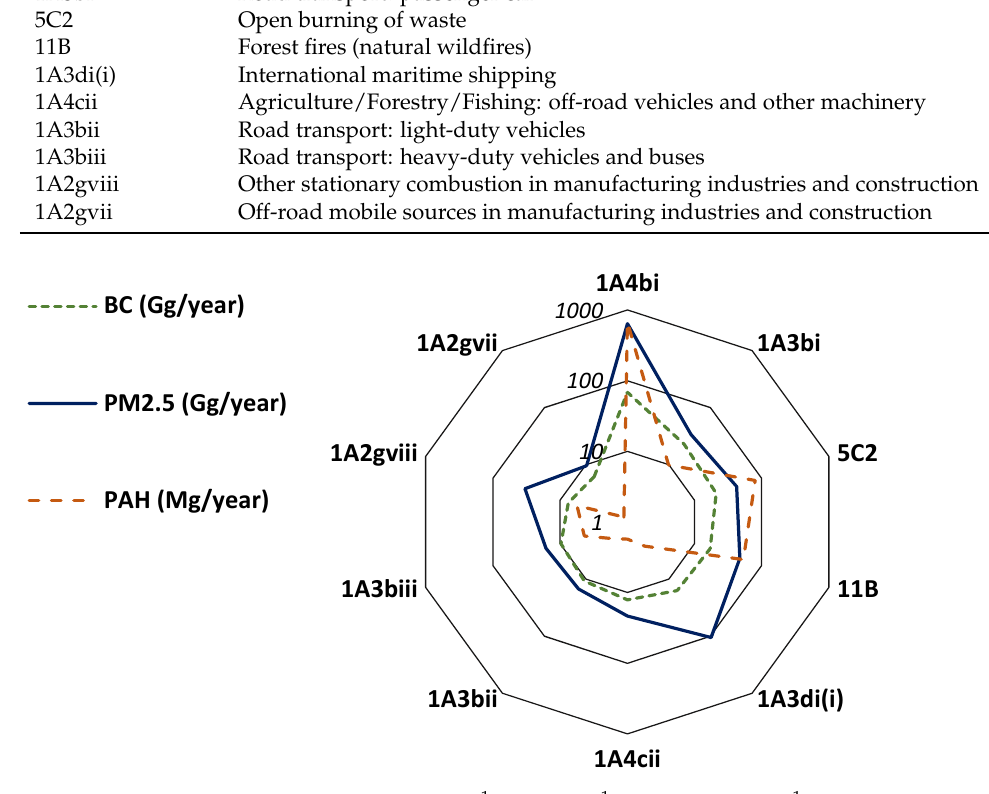
Figure 2. EU28 official emissions in kt year − 1 or t year − 1 (Gg or Mg year − 1 ) for BC, PM 2.5 and PAHs (as the sum of benzo(a)pyrene, benzo(b)fluoranthene, benzo(k)fluoranthene and indeno(1,2,3- cd)pyrene) in 2018 for the main emitting NFR sectors (refer to Table 3). Emissions are computed from the EMEP database [53].